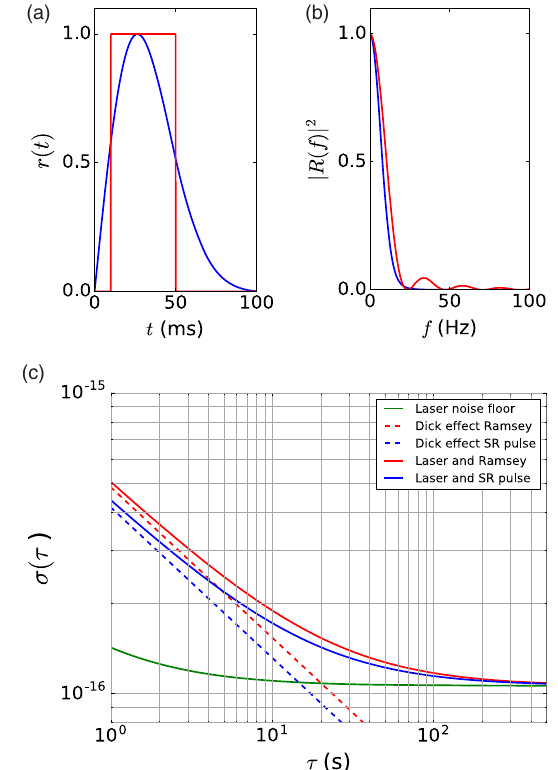
FIG. 6. Frequency noise aliasing. (a) Sensitivity function r ð t Þ for a superradiant (SR) pulse with a Gaussian power profile with duration characterized by σ ¼ 28 ms and centered at t ¼ 15 ms (blue), and for a Ramsey sequence with duration T ¼ 40 ms (red). (b) Modulus squared of the normalized Fourier transform of the sensitivity functions shown in (a). (c) Contribution to fractional Allan deviation from the reference laser, under different measurement scenarios: the Allan deviation of the reference laser, assuming no dead time in measurement (green) [33,34]; the Allan deviation contribution of the reference laser for the SR pulse as in (a) and (b) (dashed blue); the Allan deviation contribution of the reference laser for the Ramsey sequence in (a) and (b) (dashed red); the quadrature sum of laser noise and frequency aliasing for the SR pulse (solid blue); and the quadrature sum of laser noise and frequency aliasing for the Ramsey sequence (solid